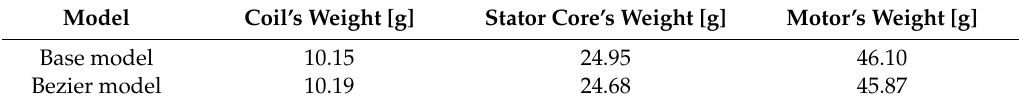
Table 2. Weight of coils, stator core, and motor for the base model and Bezier model.